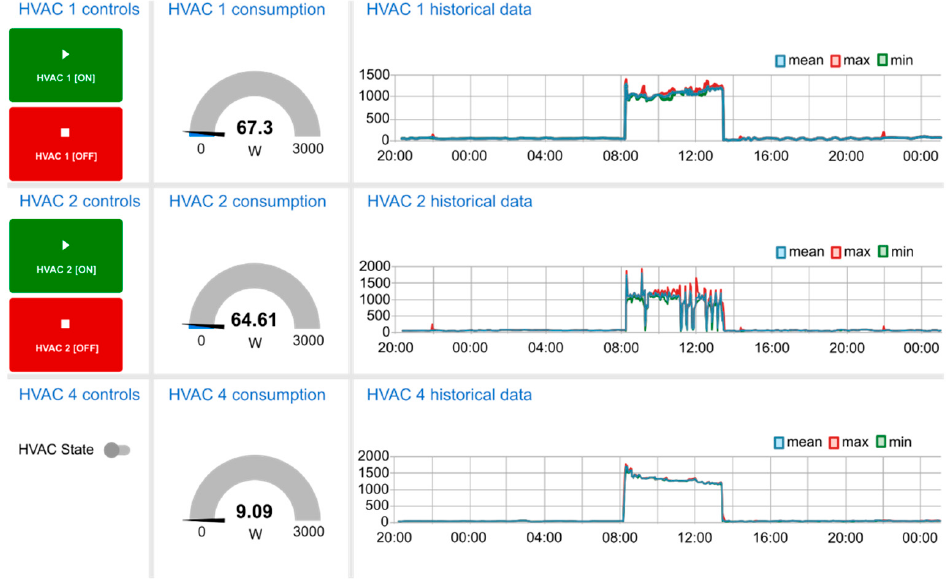
Figure 9. BMS HVAC control interface.